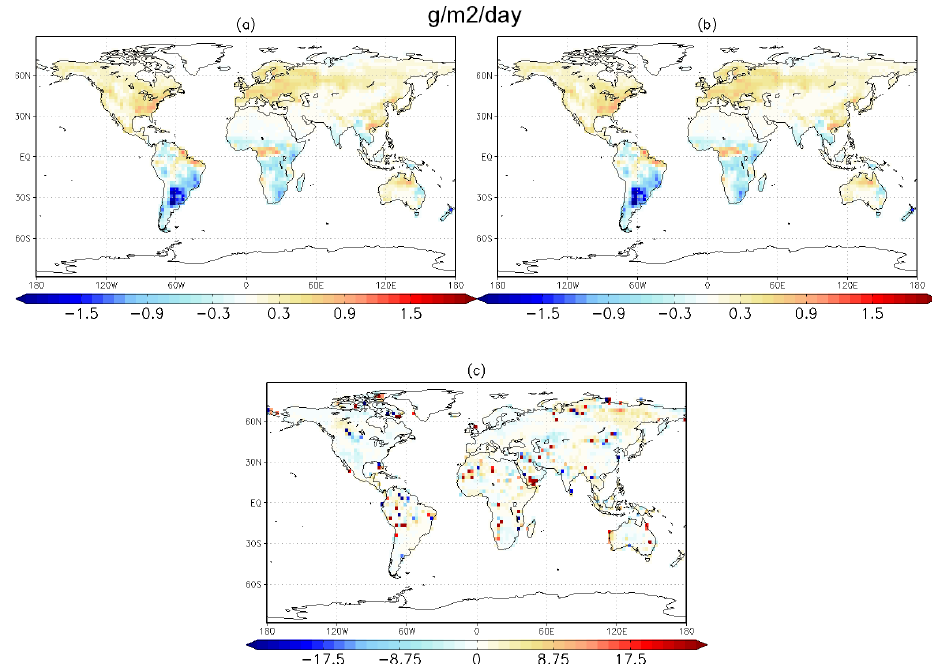
Fig. 3. Results of simulation experiment for biosphere. (a) pseudotruth, (b) recovered fluxes, (c) difference in percentage between truth and recovered